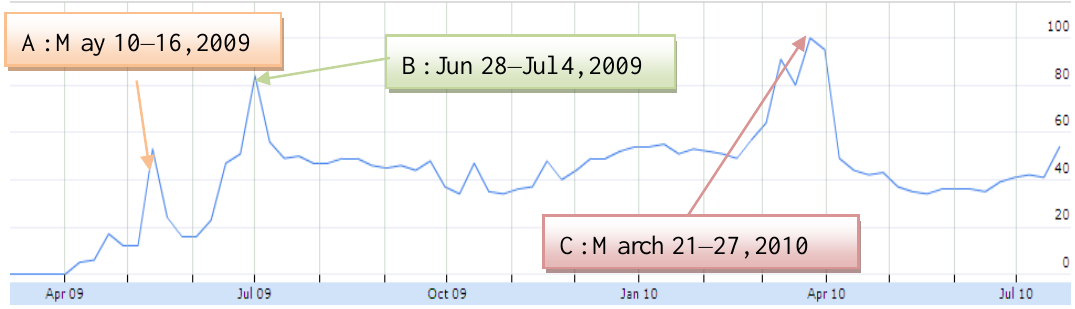
Figure 3. Index of interest shown in search term “Eko Pointo” (Graph generated by Google Insights for Search on 19 July